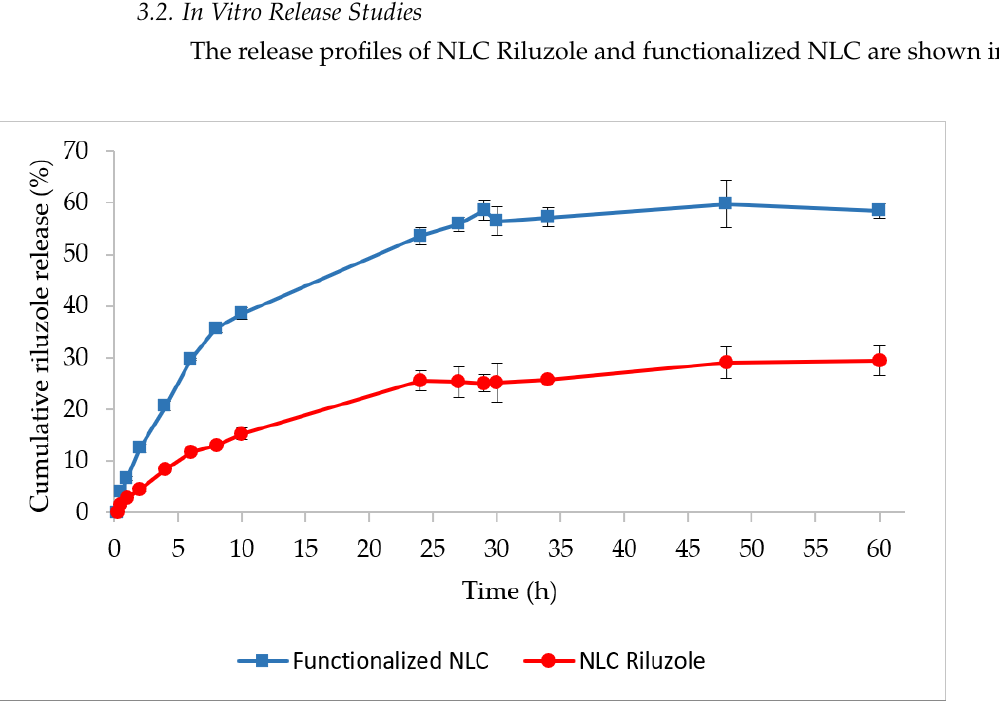
Figure 2. In vitro dissolution profiles of functionalized NLC and NLC Riluzole in PBS pH 7.4. The results for the kinetic modeling of the riluzole release profiles from the NLC are presented in Table 3. Table 3. Estimated kinetic parameters of the different mathematical models fitted to the riluzole release from NLC Riluzole and functionalized NLC.